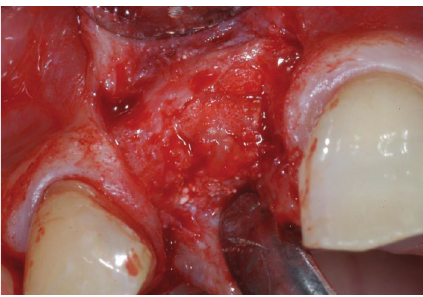
Figure 11: Six months after the grafting procedure, the patient showedgreatboneaugmentation,confirmingthepossibilitytoplace a dental implant in the proper position.